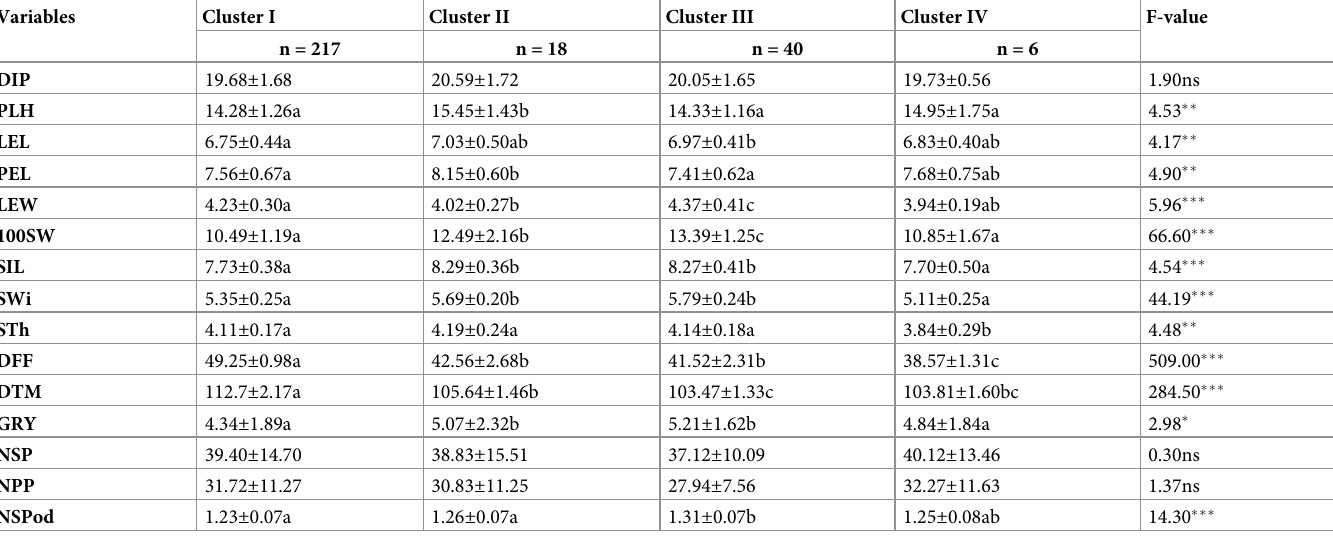
Table 7. Phenotypic means and standard deviation of clusters of Kersting’s groundnut accessions and results of F-test of differences among clusters.